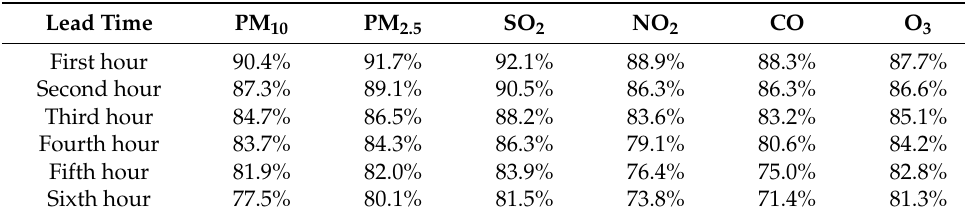
Table 17. The accuracies of the LSTM_HPO for 6 h in dataset 1.